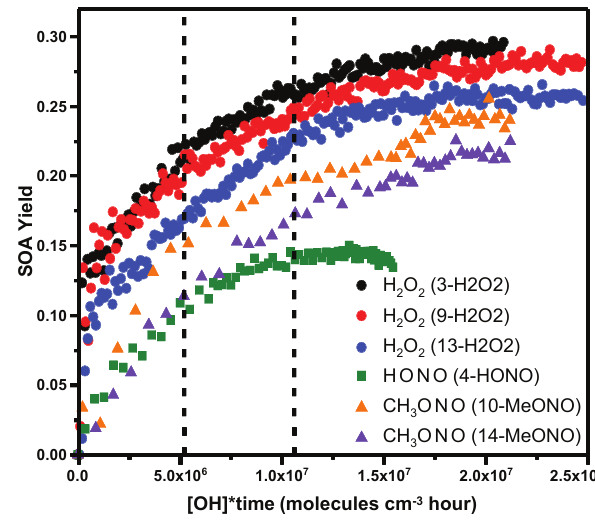
Fig. 1. SOA yield as a function of OH exposure of α -pinene from low-NO x , high-NO, and high-NO 2 OH oxidation in the presence of ammonium sulfate seed particles. The vertical dashed lines repre- sent one and two α -pinene lifetimes with respect to reaction with OH. The OH source and sample ID for each experiment is shown in the